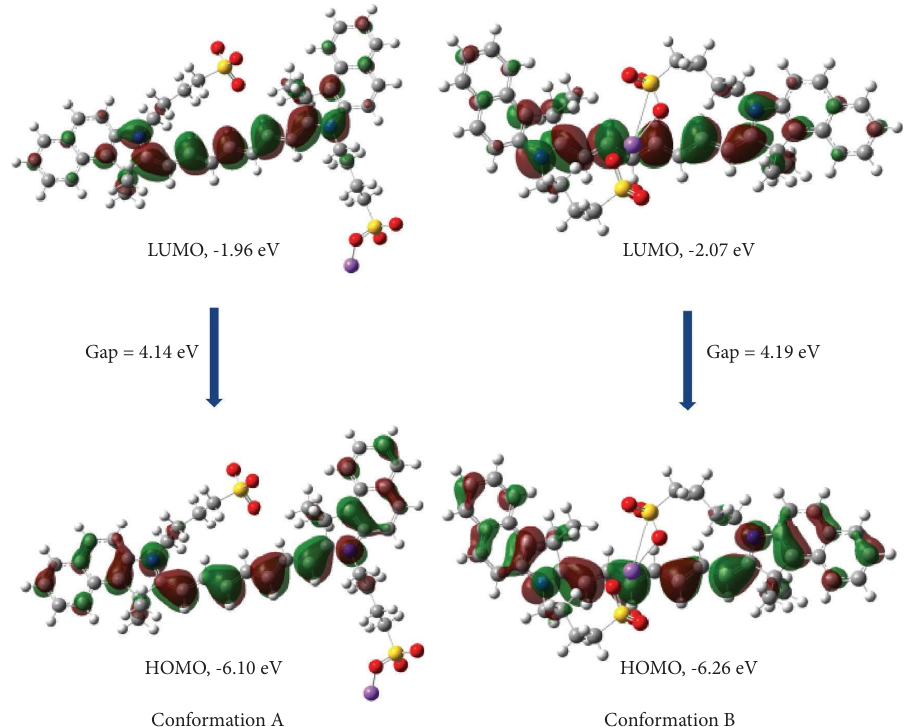
Figure 5: Distribution of frontier molecular orbital and energy gap of two diferent conformations of ICG molecule. Table 3: Te HOMO, LUMO, and energy gap of ICG versus other molecules 1 . ICG-A ICG-B ENU Cepharanthine Edotecarin